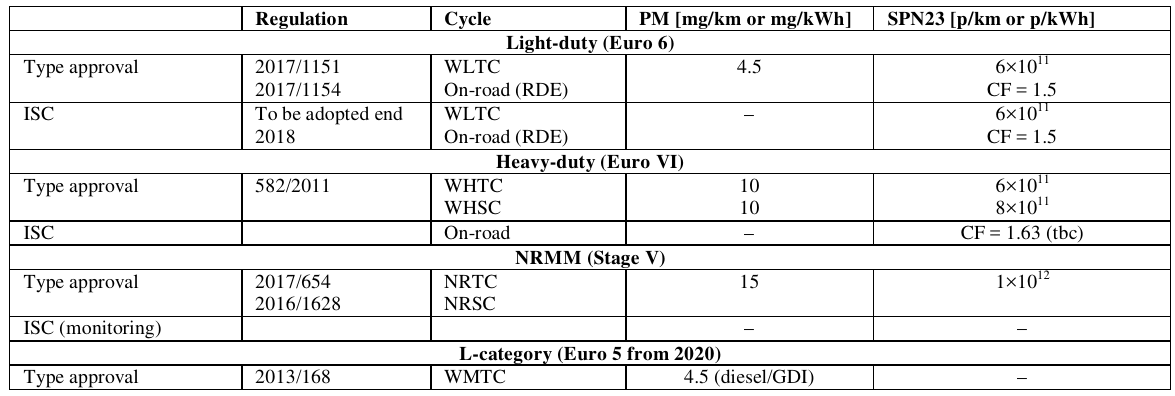
Table 1. Overview of European regulations regarding PM and SPN23 for light-duty, heavy-duty, NRMM and L-category vehicles. Status